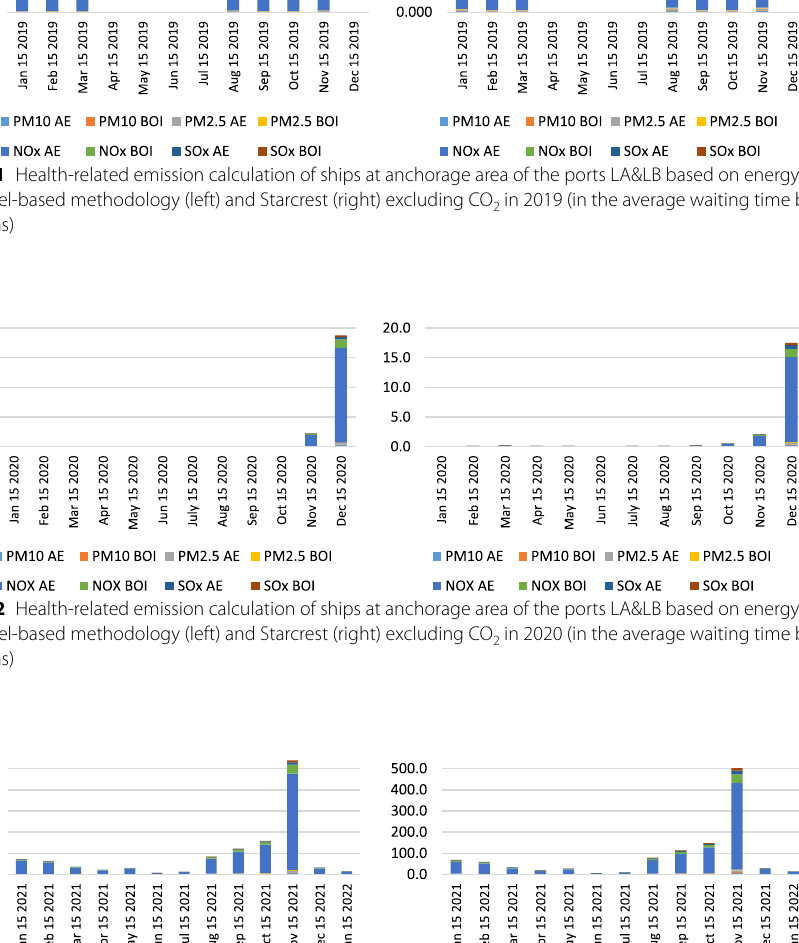
area of the ports LA&LB, based on selected methodologies from 2019 to 2021 with a monthly overview.